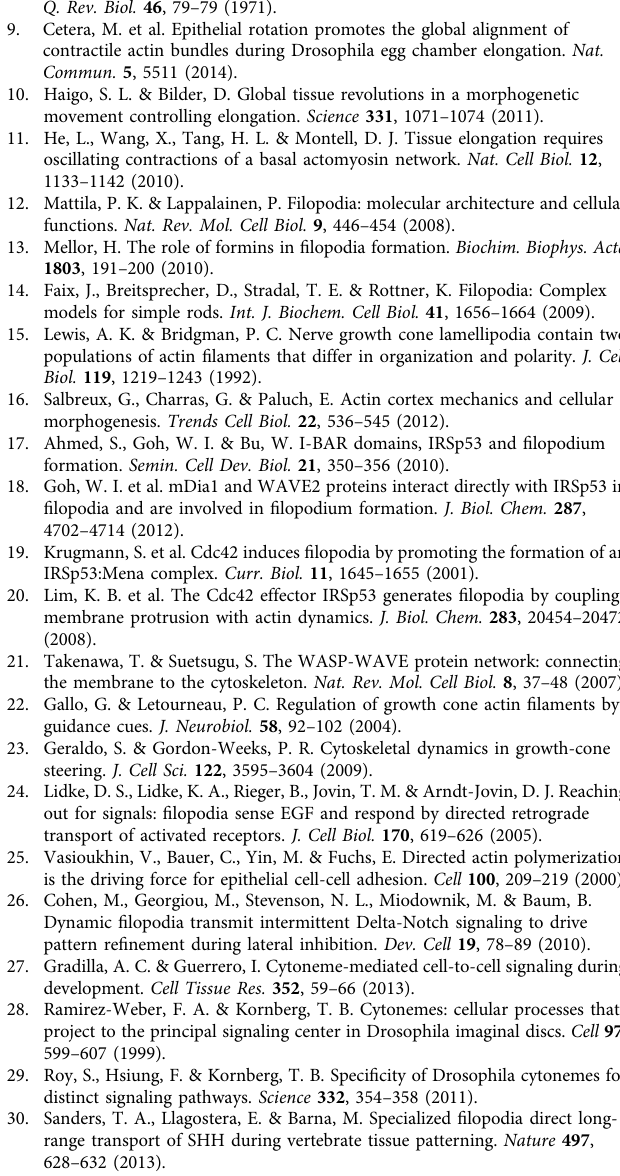
Fig. 7 Cdc42 controls DV-polarized supracellular tension and AP-directed global tissue elongation. a – c Time-lapse series of a representative egg chamber not expressing ( a , b ) and expressing ( c ) the Cdc42DN transgene marked by mCD8GFP coexpression before and after ablation (indicated by the dashed line) of the basal actomyosin network over a 100 µ m line along the AP ( a , c ) and the DV ( b ) axes. MyoII is visualized by using a MyoII-mCherry construct. d Maximum recoil speed after ablations in the n individual control (only mCD8GFP expressing) and Cdc42DN-expressing egg chambers. Data are presented as mean values + / − SEM. For the control DV vs. AP comparison: p = 0.0043; for the Cdc42DN DV vs. AP comparison: p = 0.1157; both by two-sided Mann – Whitney test. e Egg chamber morphology under the indicated genetic backgrounds at S10 and S14. Armadillo staining in red and DAPI staining in blue. f Anterior-posterior (AP) to dorsal-ventral (DV) length ratio in the n individual egg chambers under the indicated genetic backgrounds at S10 and S14. Boxes extend from the 25th to 75th percentiles, the mid line represents the median and the whiskers indicate the maximum and the minimum values. For all comparisons, p < 0.0001 by two-sided Mann – Whitney test. g Time-lapse images showing the region of contact of one mCD8GFP expressing cell with a wild-type cell before and after nano-ablating (indicated by the dashed line) stress fi bers juxtaposed to fi lopodia (white arrowhead). Circles indicate the initial positions of the fi lopodia tips juxtaposed to severed (white) or preserved (yellow) stress fi bers. Arrow heads indicate the current position of the fi lopodia. h Percentage of fi lopodia undergoing either no displacement, recoil or extension during the fi rst minute after ablation. i Time-lapse series of a representative egg chamber, before and after ablation (indicated by the dashed line) of the actomyosin network along the AP axis and across a fi lopodium. The arrowhead indicates the current position of the fi lopodium tip. Arrows indicate the actomyosin recoil directions. j Schematic representation of follicle cells and the subcellular distribution of stress fi bers and intercellular fi lopodia forming a supracellular contractile network (top panel) surrounding the egg chamber and generating tissue scale forces driving AP tissue elongation (bottom panel). Scale bars are 10 μ m in a – c , i , 50 μ m in e , and 2 µ m in g